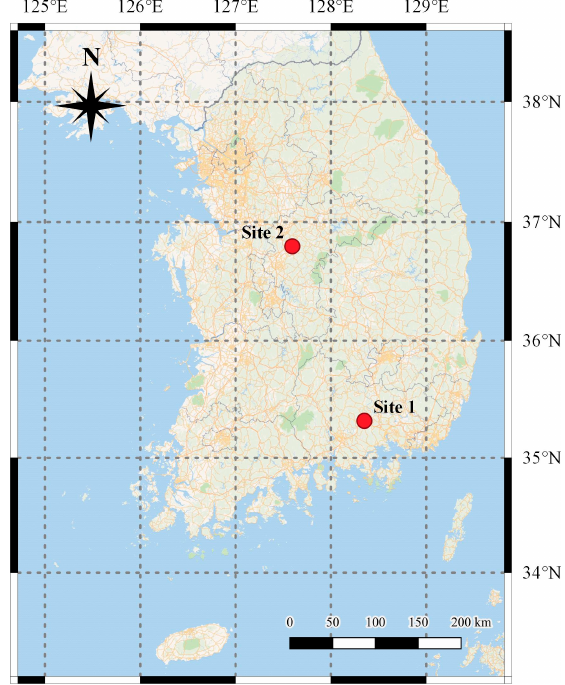
Figure 2. Basemap of the Korean peninsula showing the geographic location of the two test sites.